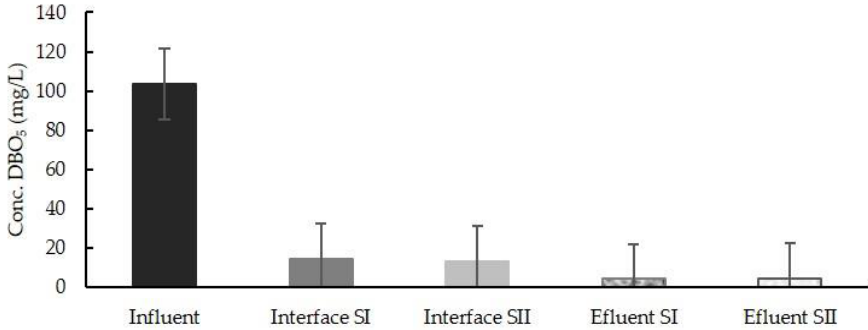
Figure 3. Comparison of BOD 5 concentrations at the three points of the PS VF wetlands during the last 23 weeks of the study.